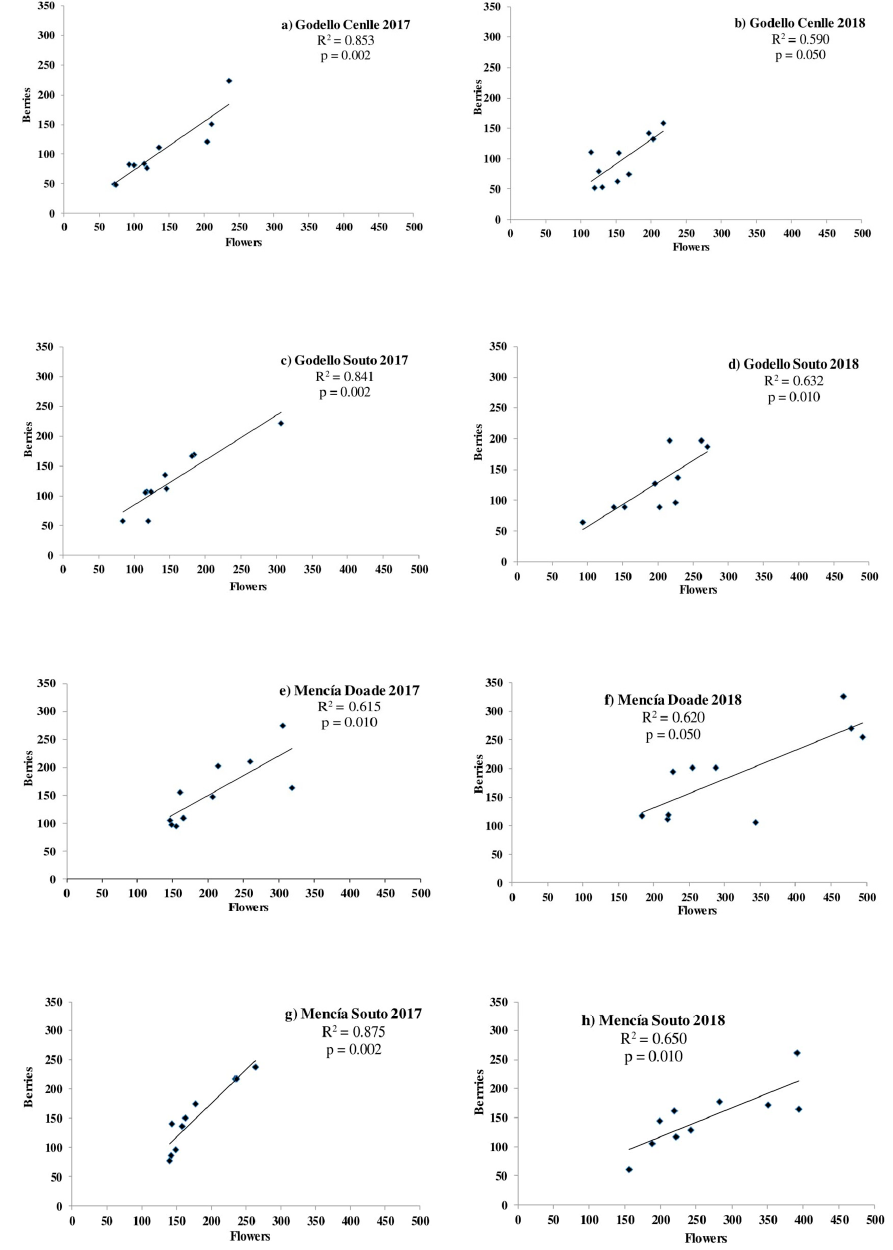
Figure 4. Linear regression analysis between flowers and berries in both grapevine varieties studied per plot, R 2 adjusted coe ffi cient of determination, and significance level (p-level) in: ( a ) Godello Cenlle 2017 (Spearman’s rank correlation = 0.9); ( b ) Godello Cenlle 2018 (Spearman’s rank correlation = 0.63); ( c ) Godello Souto 2017 (Spearman’s rank correlation = 0.9); ( d ) Godello Souto 2018 (Spearman’s rank correlation = 0.85); ( e ) Menc í a Doade 2017 (Spearman’s rank correlation = 0.84); ( f ) Menc í a Doade 2018 (Spearman’s rank correlation = 0.68); ( g ) Menc í a Souto 2017 (Spearman’s rank correlation = 0.96); ( h ) Menc í a Souto 2018 (Spearman’s rank correlation = 0.81). The continuous lines represent the linear regression